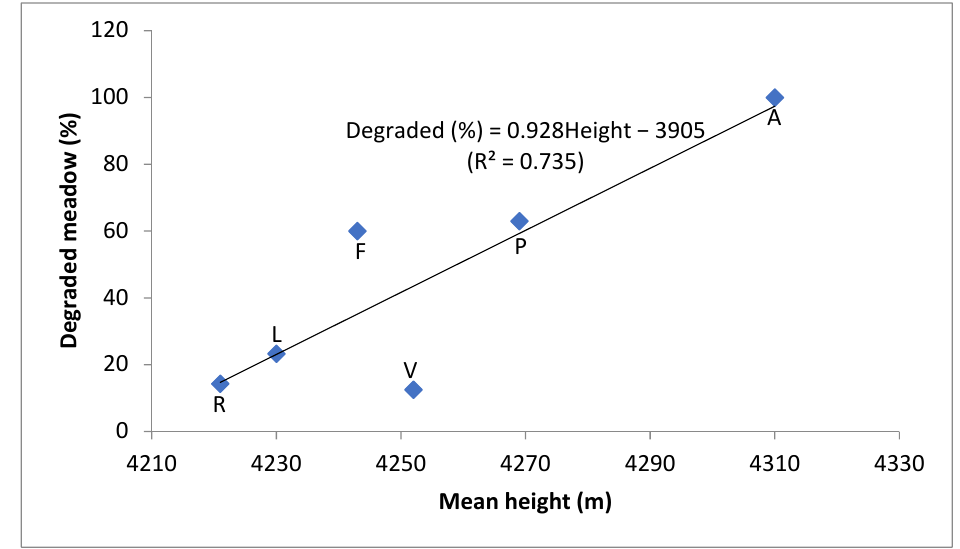
Figure 5. Regression relationship between the ratio of degraded swampy meadow sites to the total sampled sites (%) with their mean height among the six types of swampy meadow.